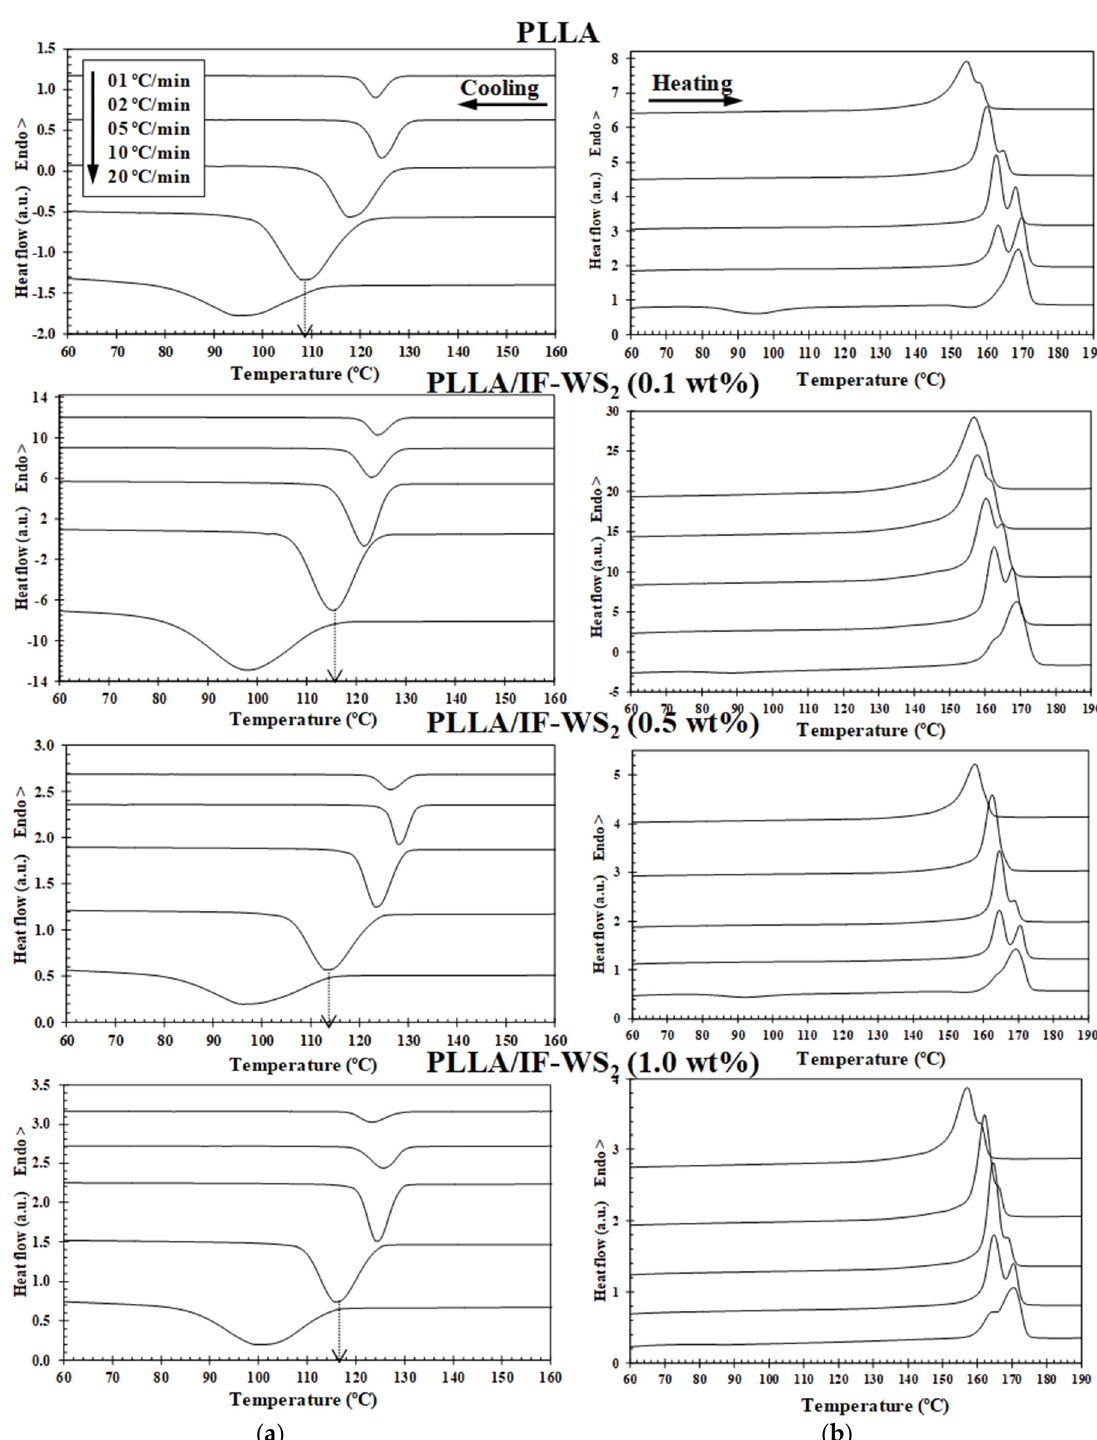
Figure 3. ( a ) Differential scanning calorimetry (DSC) melt–crystallization thermograms of PLLA and PLLA/IF-WS 2 nanocomposites with nanofiller loadings of 0.1, 0.5 and 1.0 wt% obtained at the indicated cooling rates and ( b ) second-run heating curves obtained at a constant heating rate of 10 °C/min.